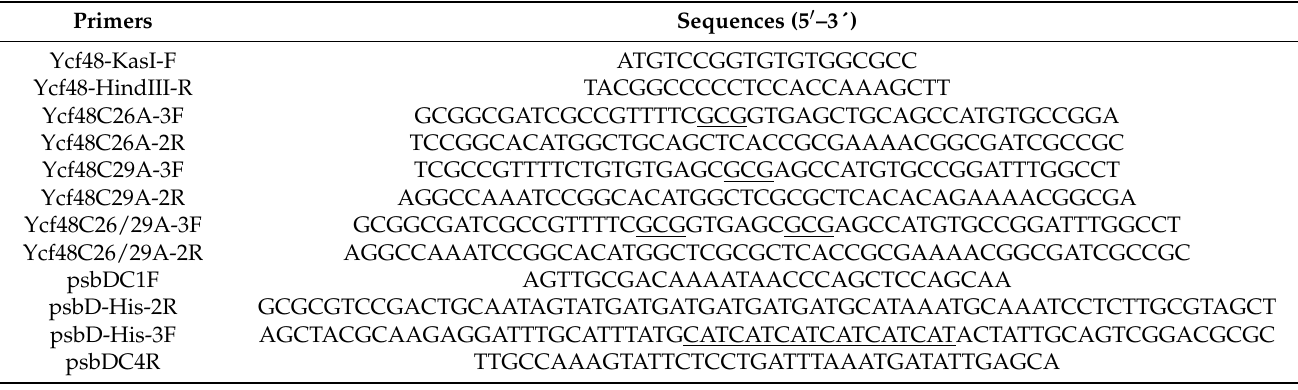
Table 2. Primers used for Ycf48C26/29A and His-D2 mutations. Modified codons and His -tag are underlined, unchanged C codons in Ycf48 positions 26 or 29 are in